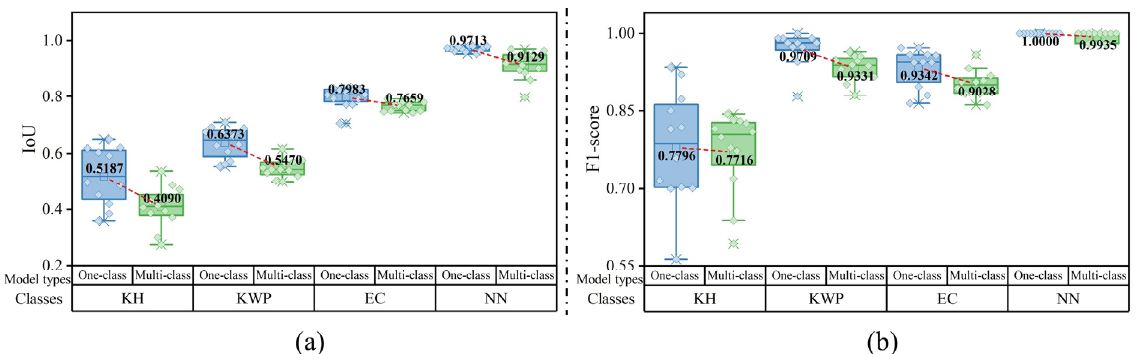
Figure 11. Statistics of accuracy of vegetation by one-class and multi-class CNN models. ( a ) IoU, ( b ) F1-score. ( b )